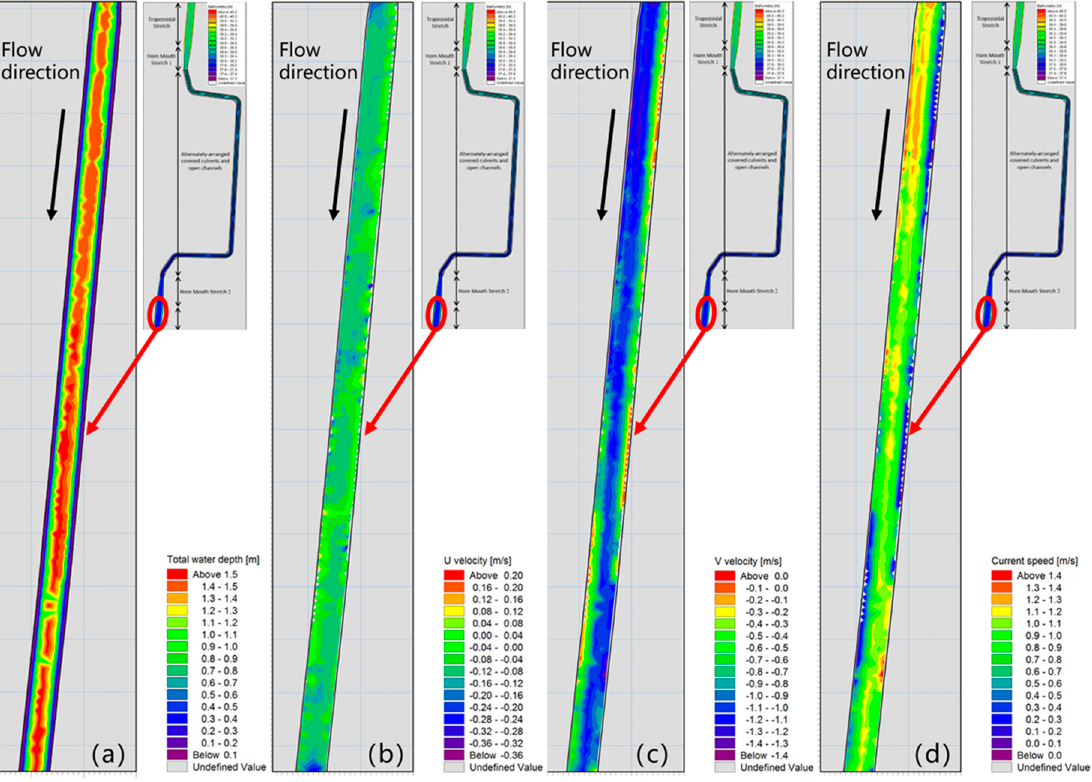
Figure 2. Hydraulic factors map of the downstream trapezoidal stretch (simulation scenario 1). ( a ) Water depth map; ( b ) Horizontal flow velocity; ( c ) Vertical flow velocity; ( d ) Current flow velocity (From bottom to top and left to right, the flow velocity was set to be positive).